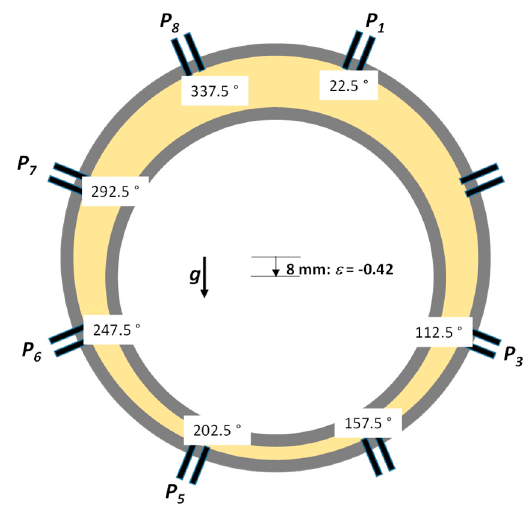
Figure 6. Schematic cross section of test section showing position of conductivity probes and inner pipe in eccentric position. Pressure ports (not shown) were located between probes 6 and 7.